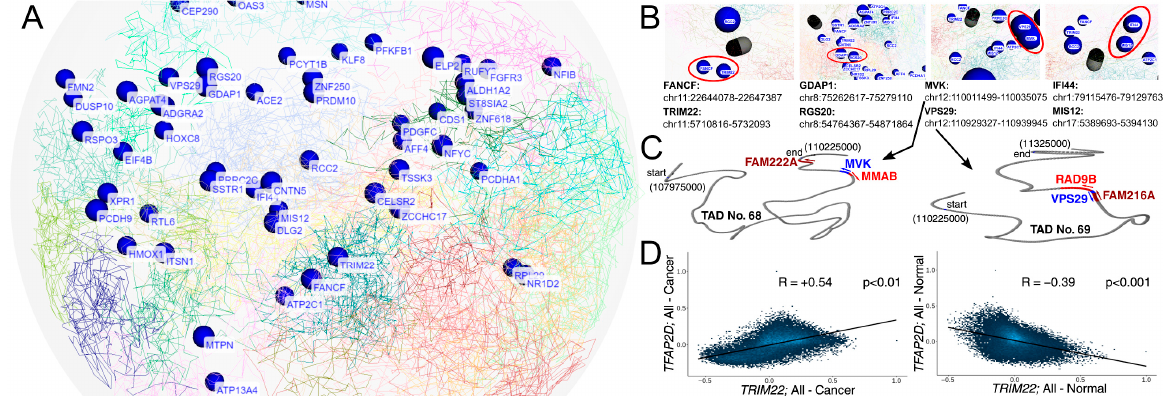
Figure 8. Insights into the three-dimensional genomic location of validated AP-2 δ targets ( A , B ), TAD domains of MVK and VPS29 ( C ), and correlation of TFAP2D with TRIM22 as the representative of TcoFs ( D ). In subfigure A, the emphasis is initially put on presenting all genes’ names at once. In subfigure B, the most interesting genomic locations were magnified and marked in red. In subfigure C, the locations of MVK and VPS29 (as well as the closest genes) are presented in TADs via TADKB. In subfigure ( D ), the CorrelationAnalyzeR was employed to correlate two genes in all available tissue types, separately for tumor and normal sample